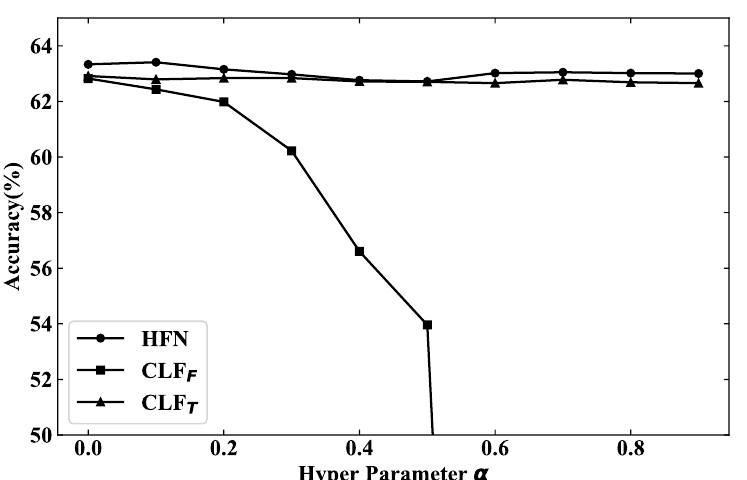
Figure 7. Benefiting from decision diversity, the hybrid neural network keeps stable results although the accuracy of CLF F drops sharply with the increasing of α